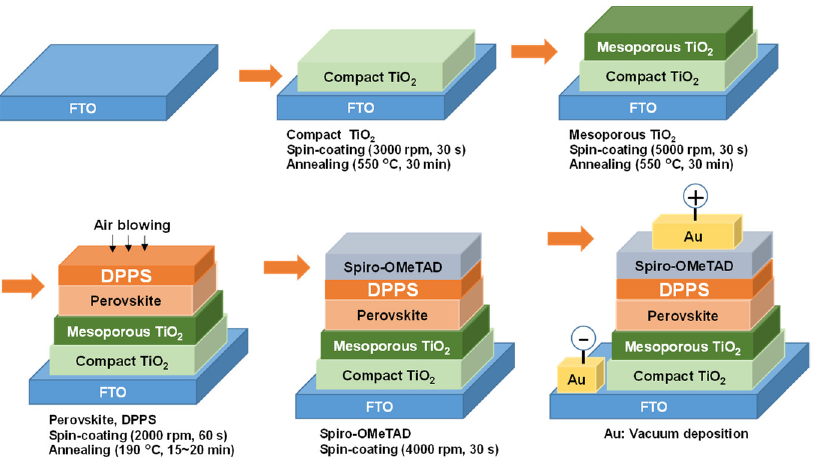
Figure 1. Schematic illustration of the process used to fabricate the present photovoltaic cells. Table 1. Compositions and calculated t -factors of the present MA 0.9 FA 0.1 Pb 1-x-y Sn x Cu y I 3 perovskite compounds.